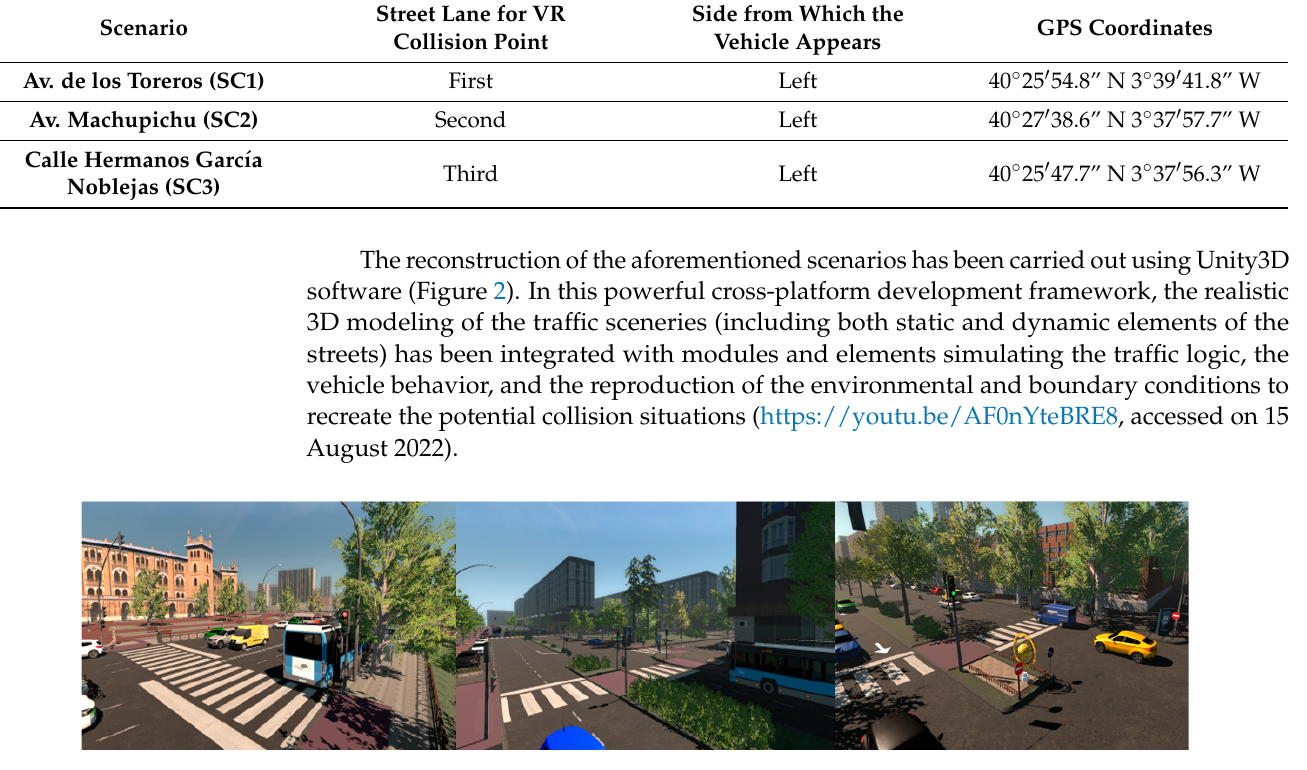
Figure 2. A 3D reconstruction of collision scenarios. From left to right: SC1, SC2, and SC3 (Madrid, Spain).